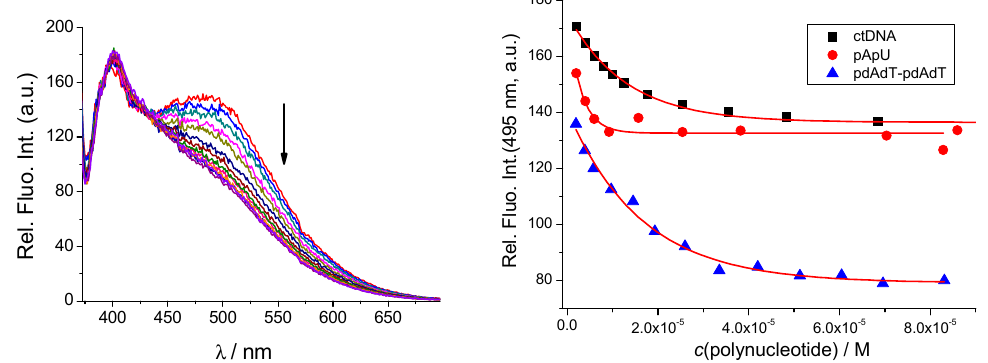
Figure 5. ( Left ): Fluorimetric titration of qAN1-pyr2 ( c = 1 × 10 − 6 M; λ exc = 350 nm) with poly (dAdT) 2 ; ( Right ): Titrations with ds-DNA/RNA at λ em = 495 nm. Performed in sodium cacodylate buffer (pH 7, I = 0.05 M) at room temperature.